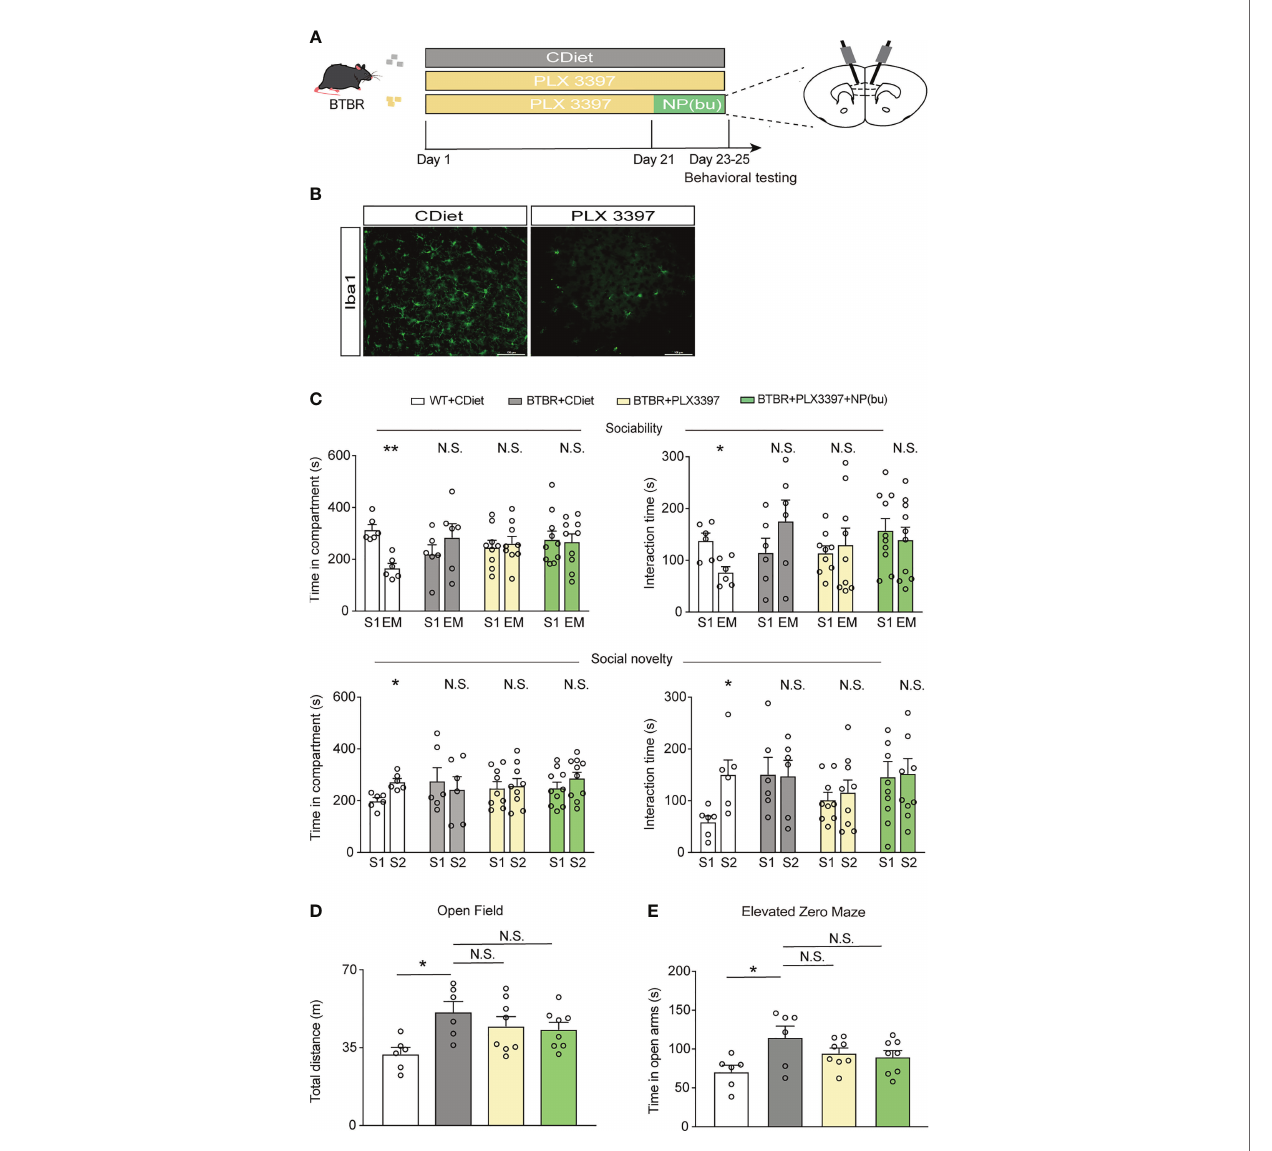
FIGURE 5 | NP(bumetanide) improved social behaviors in BTBR mice necessitate microglia in mPFC. (A) Schematic representation of the experimental procedure. Male BTBR mice were pretreated diets formulated with PLX3397 (CSF1R antagonist) or control diets for 25 days. NP(bumetanide) was provided for 3 times from day 21 and behavior tests were tested. (B) Representative Iba1 immuno fl uorescent staining from the mPFC region of CDiet (Left) and PLX3397 (Right)- treated BTBR mice. Scale bar 100 m m. (C) Top: time spent in social stimulus or empty chamber and total interaction time with stimulus mouse or empty wire during sociability stage (WT + CDiet, n = 6; BTBR + CDiet, n = 6; BTBR + PLX3397, n = 9, BTBR + PLX3397 + NP(bumetanide), n = 10, paired Student ’ s t -test. Time in compartments, ** p <0.01, WT + CDiet S1 vs. EM; N.S., not signi fi cant, BTBR + CDiet S1 vs. S2; N.S., not signi fi cant, BTBR+PLX3397 S1 vs. S2; N.S., not signi fi cant, BTBR+PLX3397+NP(bumetanide) S1 vs. EM; interaction time, * p <0.05, WT + CDiet S1 vs. EM; N.S., not signi fi cant, BTBR + CDiet S1 vs. EM; N.S., not signi fi cant, BTBR+PLX3397 S1 vs. EM; N.S., not signi fi cant, BTBR+PLX3397+NP(bumetanide). Bottom: time spent in familiar or novel stimulus chamber and total interaction time with familiar or novel stimulus mouse during social novelty stage (paired Student ’ s t -test. Time in compartments, * p <0.05, WT + CDiet S1 vs. S2; N.S., not signi fi cant, BTBR + CDiet S1 vs. S2; N.S., not signi fi cant, BTBR + PLX3397 S1 vs. S2; N.S., not signi fi cant, BTBR + PLX3397 + NP(bumetanide) S1 vs. S2; interaction time, * p <0.05, WT + CDiet S1 vs. S2; N.S., not signi fi cant, BTBR + CDiet S1 vs. S2; N.S., not signi fi cant, BTBR + PLX3397 S1 vs. S2; N.S., not signi fi cant, BTBR + PLX3397 + NP(bumetanide) S1 vs. S2). (D) Total distance traveled in the open- fi eld test (WT + CDiet, n = 6; BTBR + CDiet, n= 6; BTBR + PLX3397, n =8; BTBR + PLX3397 + NP(bumetanide), n = 8, one-way ANOVA, F(3,24) = 3.704, p =0.0254, Bonferroni post hoc : * p < 0.05, WT + CDiet vs. BTBR + CDiet; N.S., not signi fi cant, BTBR + CDiet vs. BTBR + PLX3397; N.S., not signi fi cant, BTBR + CDiet vs. BTBR + PLX3397 + NP(bumetanide). (E) Time spent in the open arm in elevated zero maze test (WT + CDiet, n = 6; BTBR + CDiet, n= 6; BTBR + PLX3397, n =8; BTBR + PLX3397 + NP(bumetanide), n = 8, one-way ANOVA, F(3,24) = 3.326, p =0.0366, Bonferroni post hoc : * p < 0.05, WT + CDiet vs. BTBR + CDiet; N.S., not signi fi cant, BTBR + CDiet vs. BTBR + PLX3397; N.S., not signi fi cant, BTBR + CDiet vs. BTBR + PLX3397 + NP(bumetanide). Data were presented as mean ±